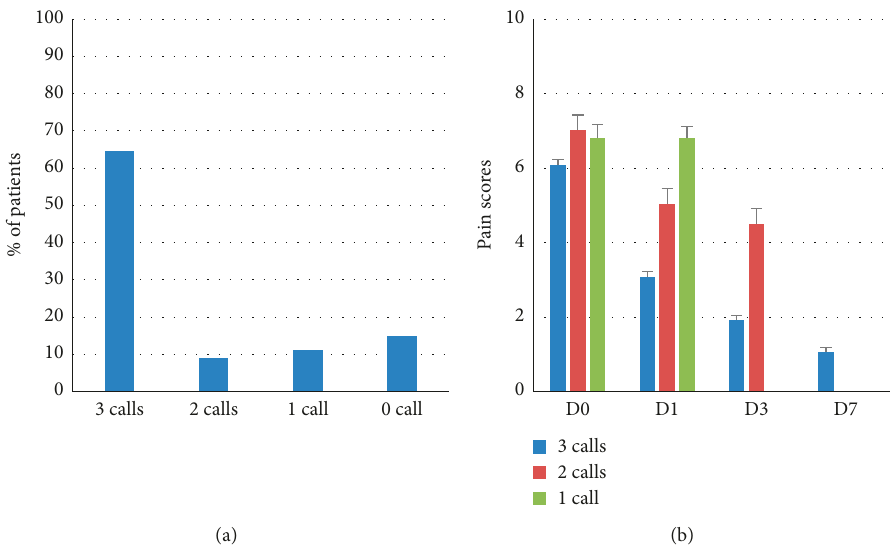
Figure 4: Pain status of responders and nonresponders to phone calls. (a) Percentage of patients responding to phone calls. (b) Pain score according to the number of calls.